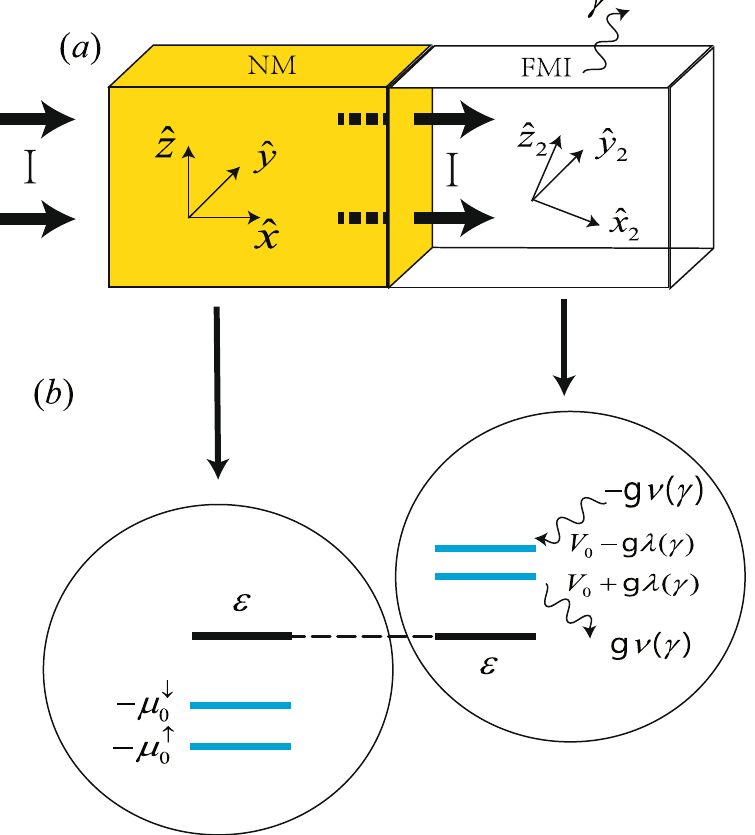
Figure 1. ( a ) Schematic illustration of the NM/FMI bilayer. γ denotes the spin relaxation rate. ( b ) The energy levels near the NM/FMI interface are plotted for the case of ν ( γ ) > 0. Note that all energy levels for FMI are larger than the NM except the lowest